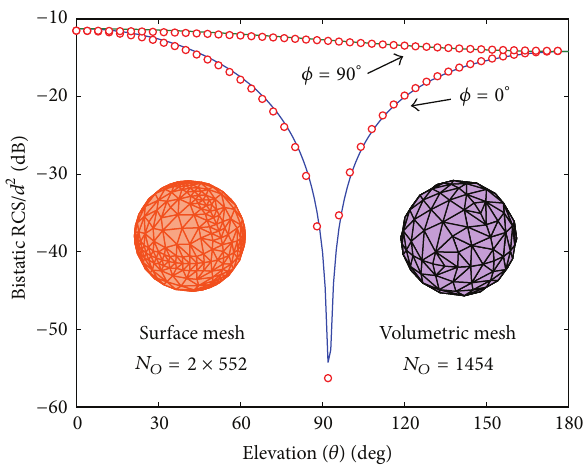
Figure 4: Example of validation in far field: bistatic RCS of a dielectric sphere embedded in a cubic brick; ( − ) solution obtained through LEGO and PMCHWT [14], ( ∘ ) solution obtained through LEGO and VIE (14). Insets: surface and volumetric meshes of the sphere. (See Figure 3 for the surface of mesh of the cubic brick.) Data : brick’s edge 10cm, sphere’s radius 4 cm, 𝜀 1 = 𝜀 2 = 𝜀 0 , 𝜀 3 = 2𝜀 0 I , E 𝑖 = ̂ x exp (−𝑗2𝜋𝑓𝑧/𝑐